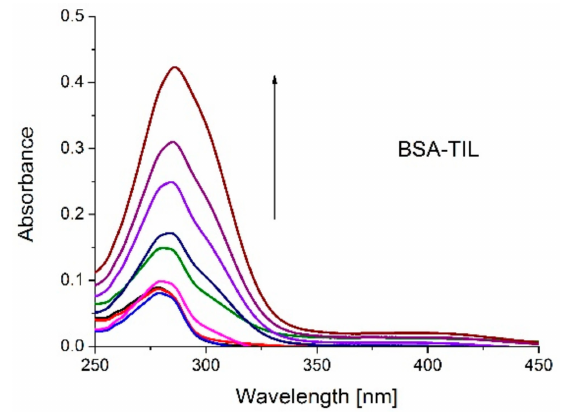
Figure 2. UV-vis absorption spectra of increasing TIL concentrations (0–15 µ M) in the presence of 2 µ M